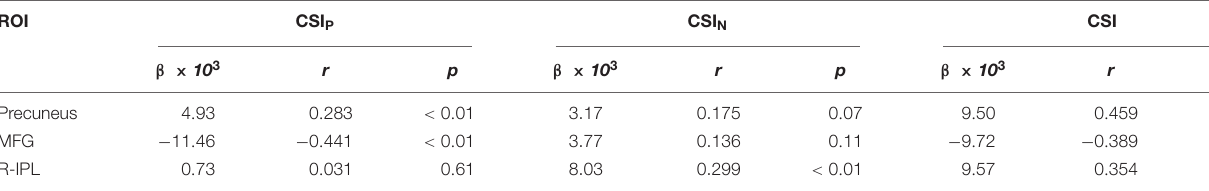
TABLE 4 | The linear regression results for the 3 ROIs with significant correlation between CSI and the subject’s age. ROI CSI P CSI N CSI β × 10 3 r p β × 10 3 β × 10 3 p Precuneus